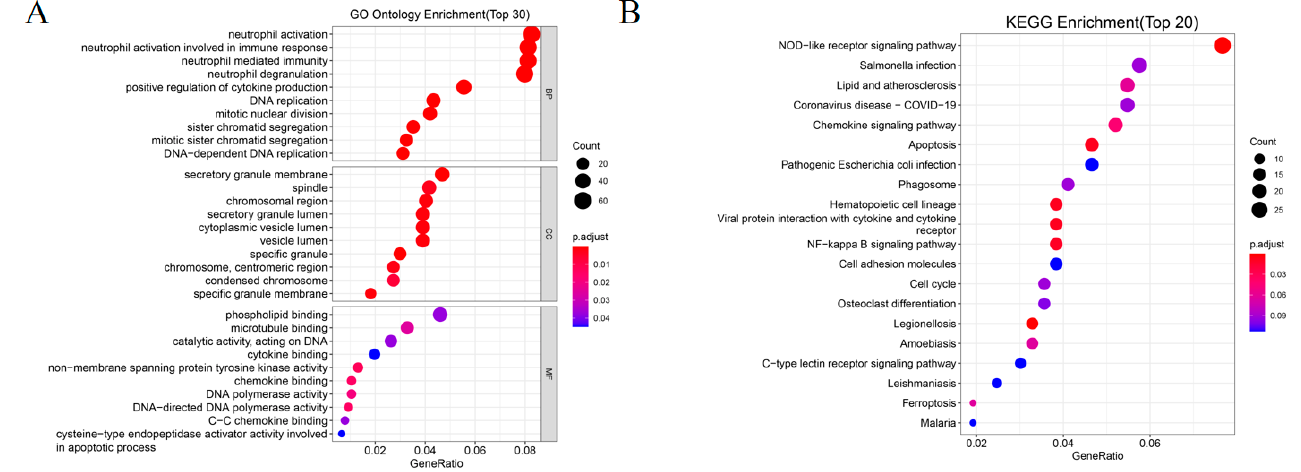
Figure 10. Functional enrichment analysis based on the DEGs between high-risk and low-risk groups in the TCGA-TARGET cohort. ( A ) Bubble graph for GO enrichment (BP: biological process, CC: cellular component, MF: molecular function; p .adjust: the adjusted p -value). ( B ) Bubble graph for KEGG pathways.